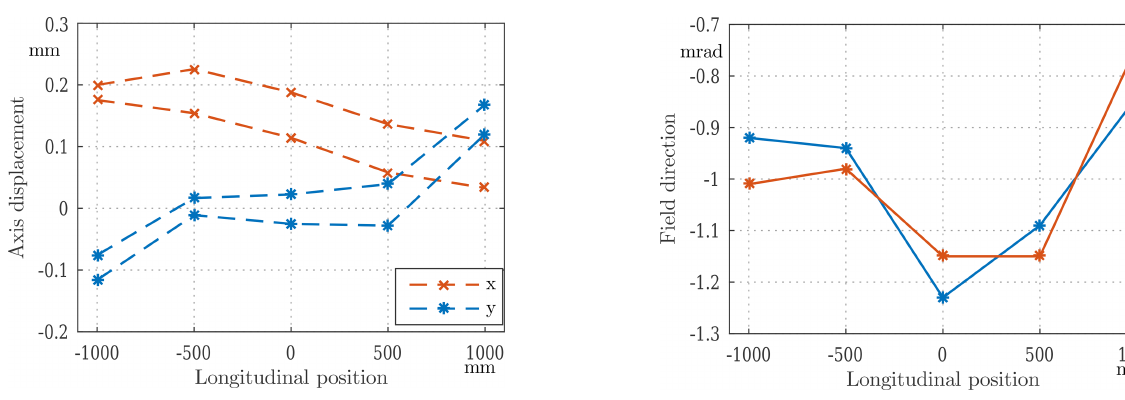
Figure 13. Field direction measurement results. Second configura- tion, with the level meter mounted directly on the encoder. The two scans were taken 4d